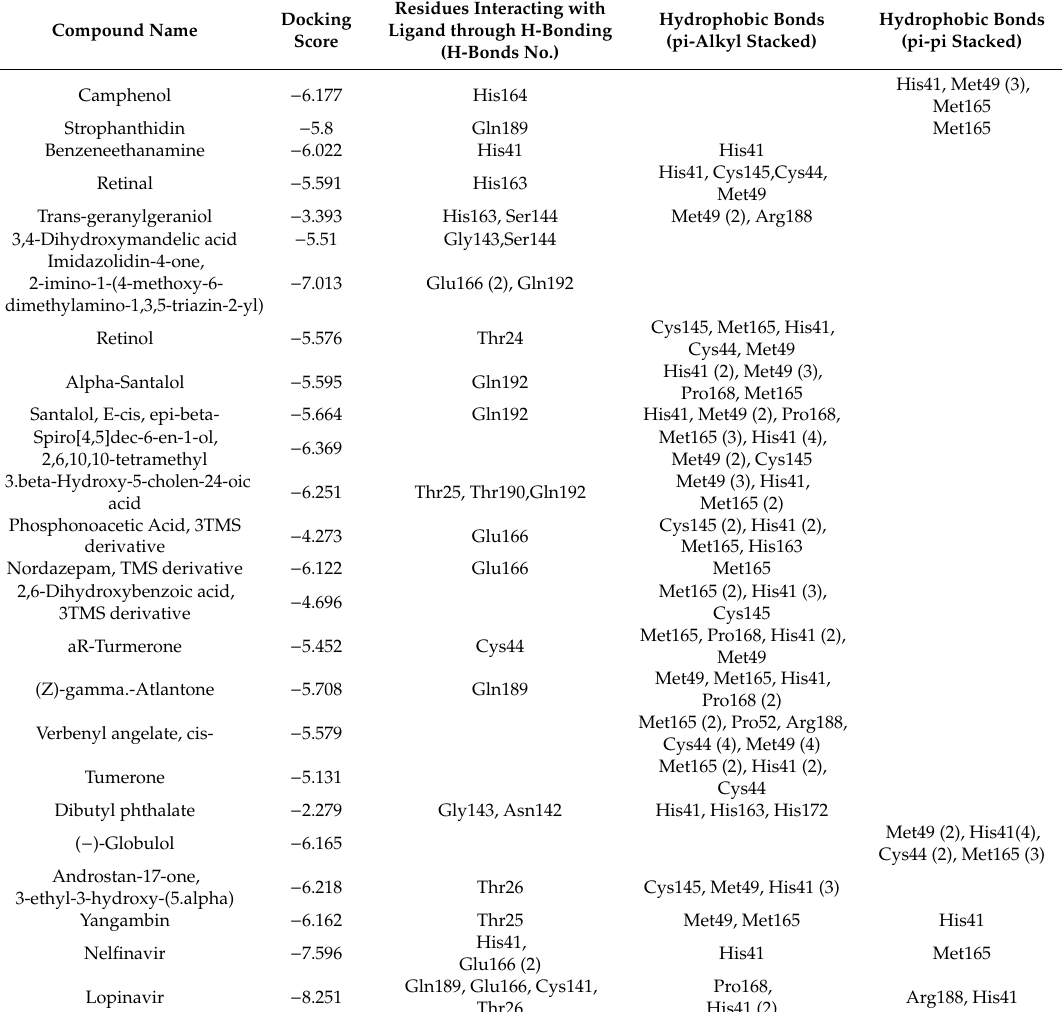
Table 3. Molecular docking study of major bioactive compounds of methanol extract of T.